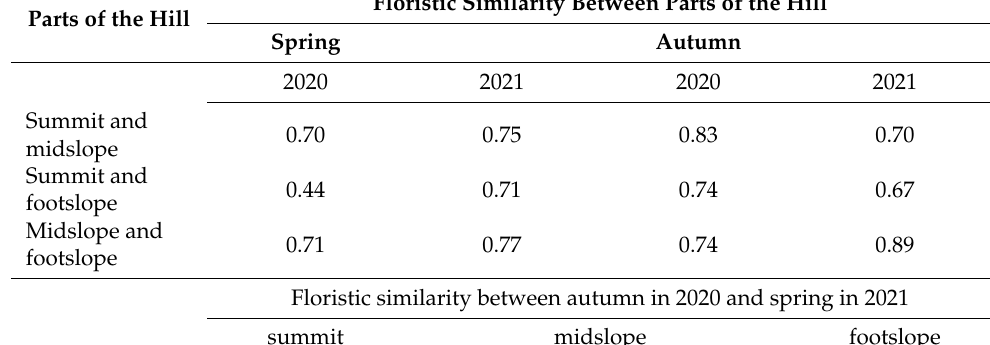
Table 1. Floristic similarity coefficients of Sörensen (Cs). Floristic Similarity Between Parts of the Hill Parts of the Hill Spring